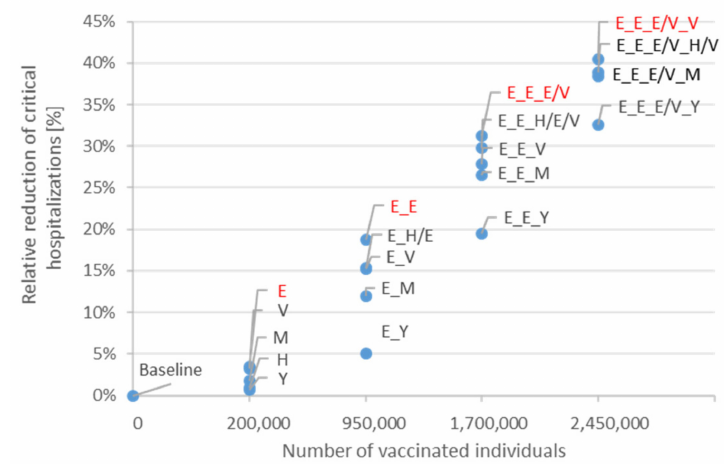
Figure A4. Cumulative relative reduction of hospitalizations (ICU) for each stepwise optimization step for a vaccine inducing non-sterilizing immunity in comparison to no vaccination (maximizing relative reduction in deaths). E—elderly ( ≥ 65 years); H—healthcare workers; M—middle-aged persons (45–64 years); V—vulnerable, individuals with increased risk of severe disease once infected; Y—persons of younger age (15–44 years); and ICU—intensive care unit. Vaccination strategies are described by stepwise provision of vaccines to population groups. For example, E_E_Y means that with the first batch 200,000 elderlies were vaccinated, followed by the second batch to vaccinate again 750,000 elderlies and followed by the third batch to vaccinate 750,000 persons of younger age. A split of a batch among two population groups is symbolized by /. The strategy colored in red provided the best outcome in terms of relative reduction of deaths in the stepwise optimization as evaluated and displayed in Figure A1. The analysis assumed a vaccine effectiveness of 70% in the general population and of 60% in the age group